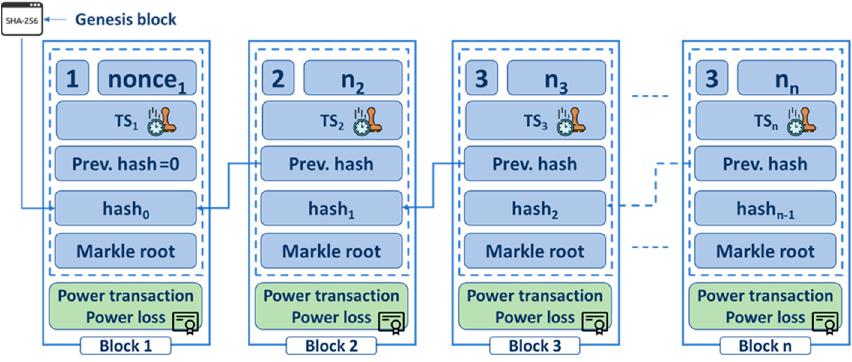
Figure 3. Energy blockchain structure.